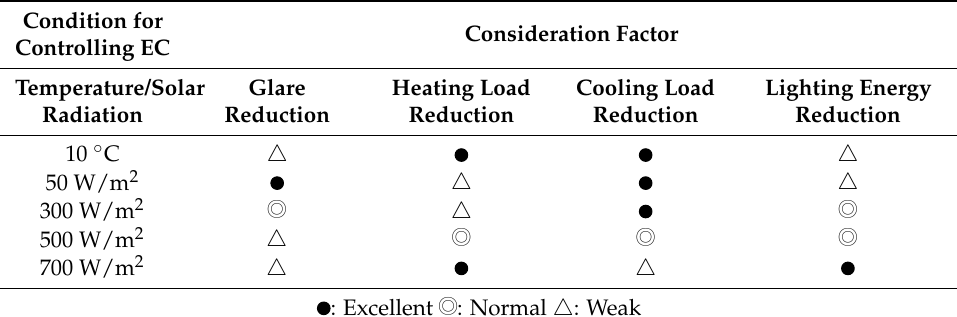
Table 3. Performance expected for each condition to control electrochromic glass.